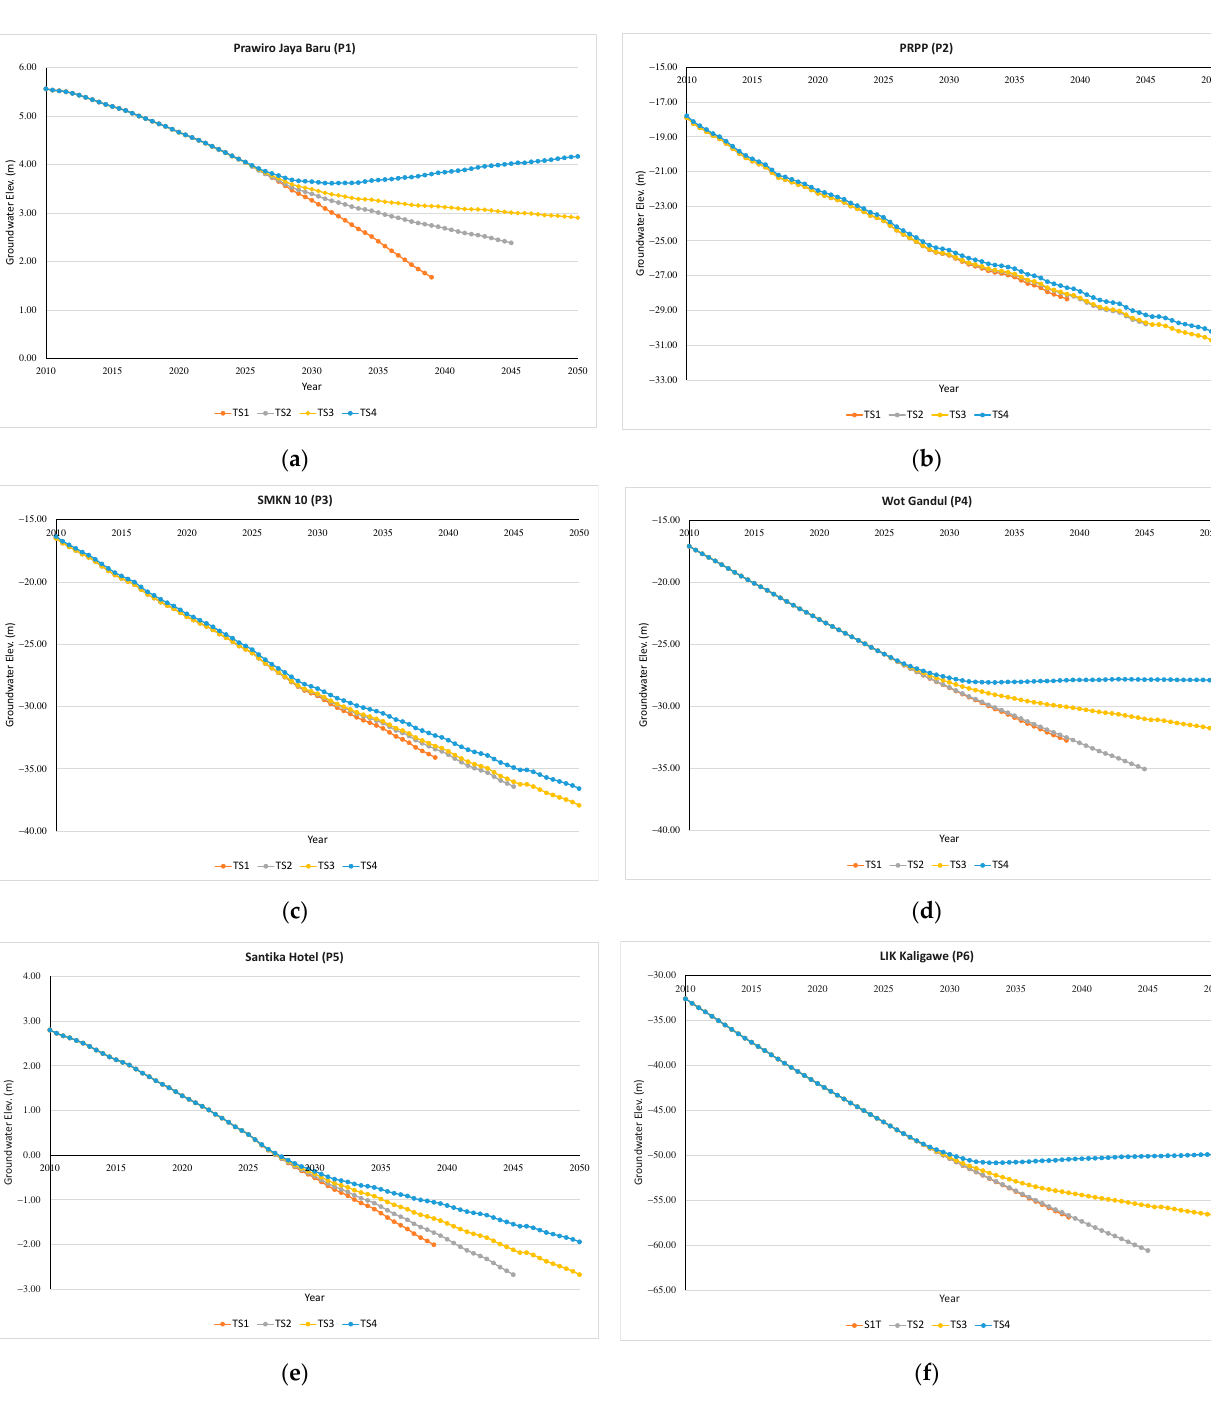
Figure 9. Simulation results for the four scenarios in the six observation wells: ( a ) Prawiro Jaya Baru (P1); ( b ) PRPP (P2); ( c ) SMKN 10 (P3); ( d ) Wot Gandul (P4); ( e ) Santika Hotel (P5); ( f ) LIK Kaligawe (P6).